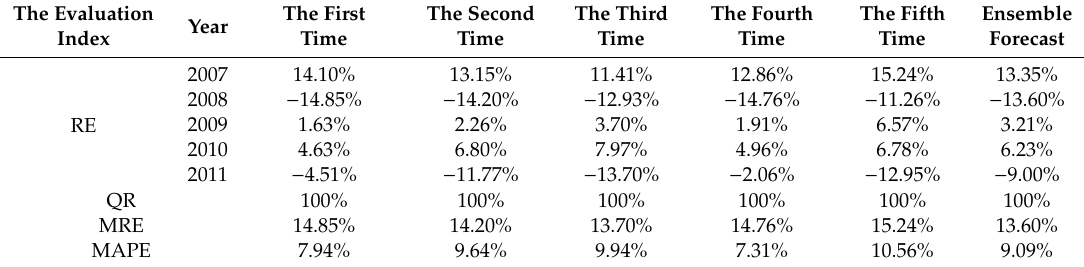
Table 7. Prediction error of single model in the verification